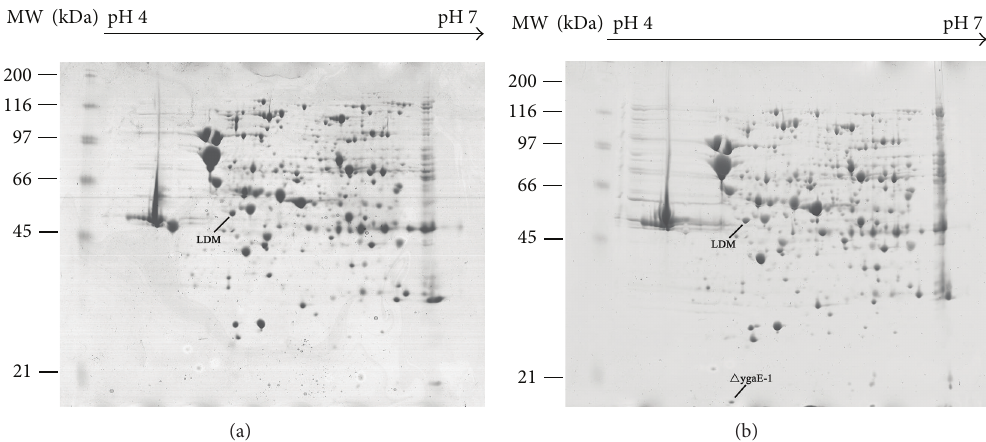
Figure 5: Two-dimensional electrophoresis was performed to compare the profiles of bacterial total proteins in wild-type strain and Δ ygaE strains after 120min hyperosmotic shock. Protein spots that were unique to each strain were chosen for mass spectroscopy (MS) analysis. Δ ygaE -1 spot, which was discussed in this study, was unique to Δ ygaE strain and determined by MS to be the out membrane protein